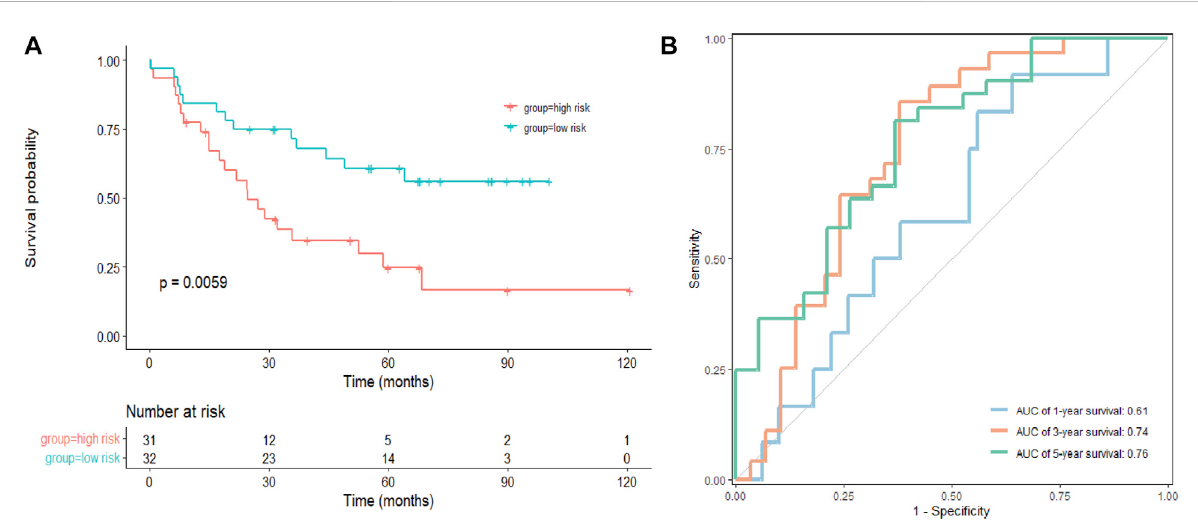
FIGURE 5 Validation ofthesignatureinaGEO cohort. (A) Kaplan – Meiersurvivalanalysis oftheriskmodelinGSE22138,andcomparisonsamongdifferent groups were performed using the log-rank test. (B) The ROC curve and AUC of the signatures of 1-, 3- and 5-year